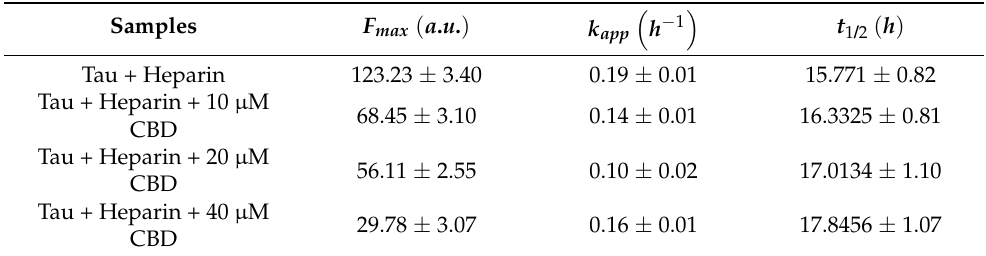
Table 2. Kinetic parameters of different CBD concentrations on tau protein aggregation collected from the best fit. By increasing CBD concentration, the kinetic values were significantly decreased. All data points are given as mean ± SD of three independent measurements ( n = 3).